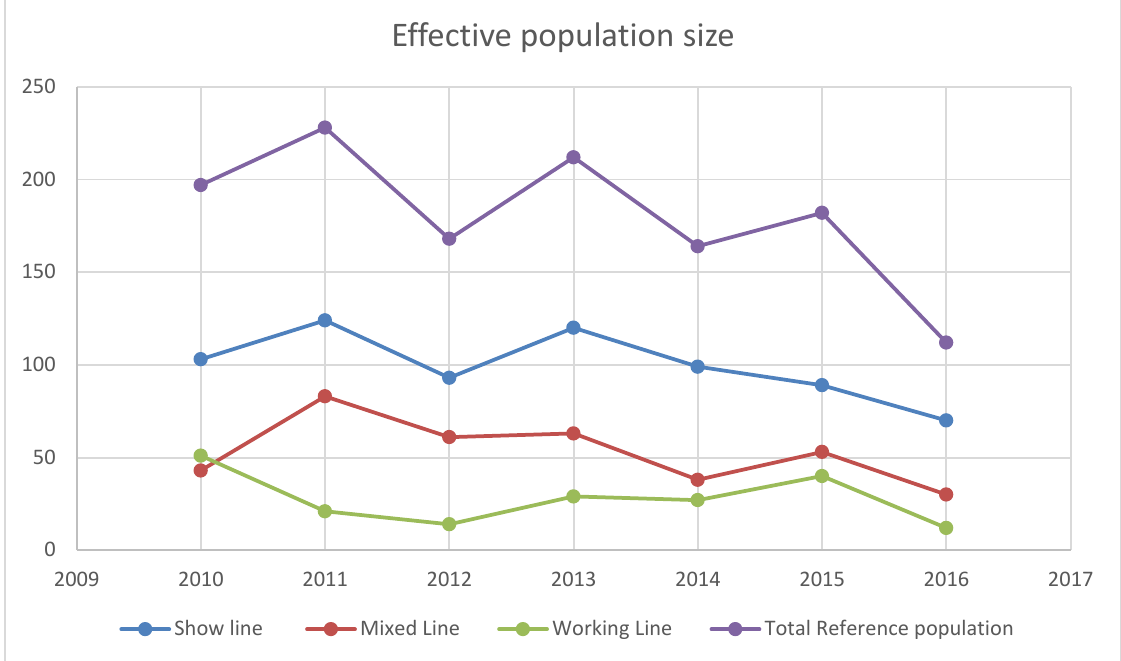
Figure 1. Effective population size (Ne) of the reference population. Figure 1. E ff ective population size (Ne) of the reference